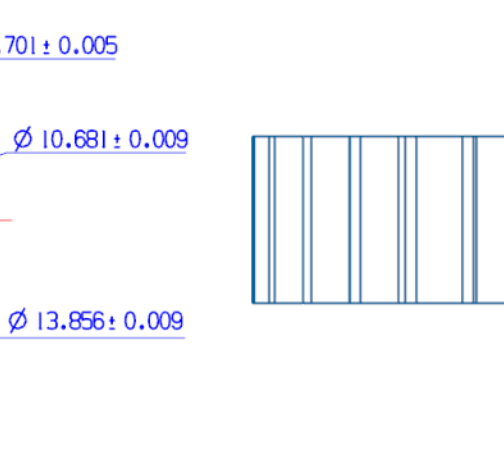
Figure 3. Front view and side view of gears.